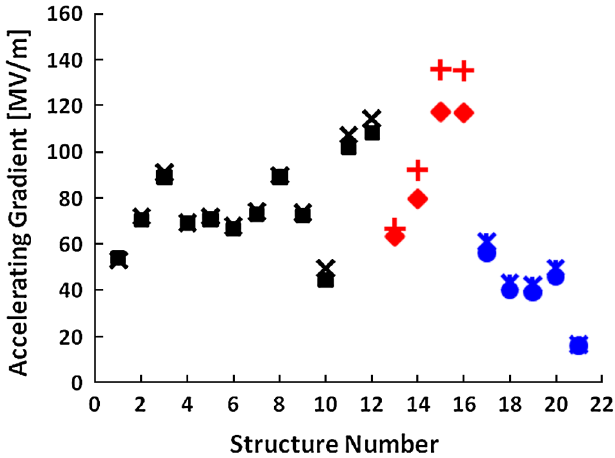
FIG. 2. (Color) Accelerating gradient for the structures from Table I scaled to the pulse length of 200 ns and BDR of 1 (cid:4) 10 (cid:5) 6 bpp ( (cid:4) —X-band TWSs, +—X-band SWSs, *—30 GHz TWSs) and to the pulse length of 200 ns and BDR of 1 (cid:4) 10 (cid:5) 6 bpp = m ( h —X-band TWSs, e —X-band SWSs, d — 30 GHz TWSs). Structure number is as in Table